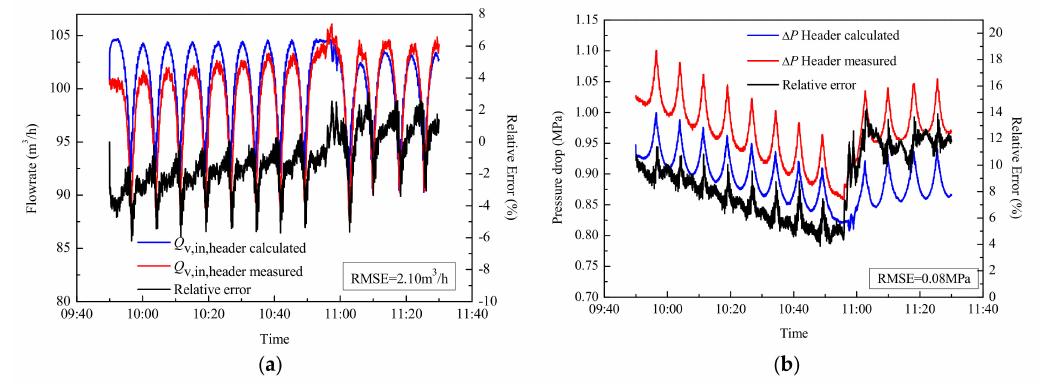
Figure 13. Compared results between calculated and measured data in a hot test for the ( a ) header inlet flow rate, and ( b ) header pressure drop.